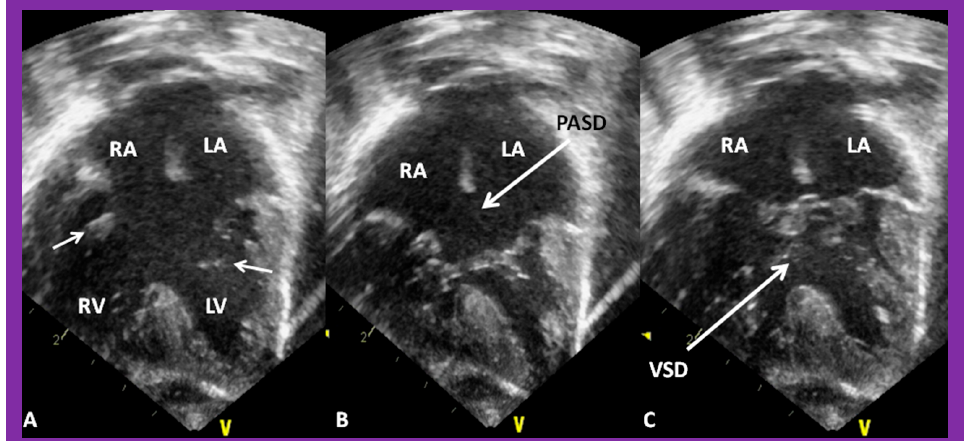
Figure 42. Echo images in apical four-chamber projections demonstrating the connection of a common atrioventricular valve with the right (RV) and left (LV) ventricles. In ( A ) (small arrows), the atrioventricular (AV) valve is open, whereas the AV valve is closed in ( B , C ) during varying phases of the cardiac cycle. Atrial septal defect of ostium primum (PASD) type of large size in ( B ), as well as a large ventricular septal defect (VSD) in ( C ), are illustrated. LA, left atrium; LV, left ventricle; RA, right atrium; RV, right ventricle. Replicated from reference [41].